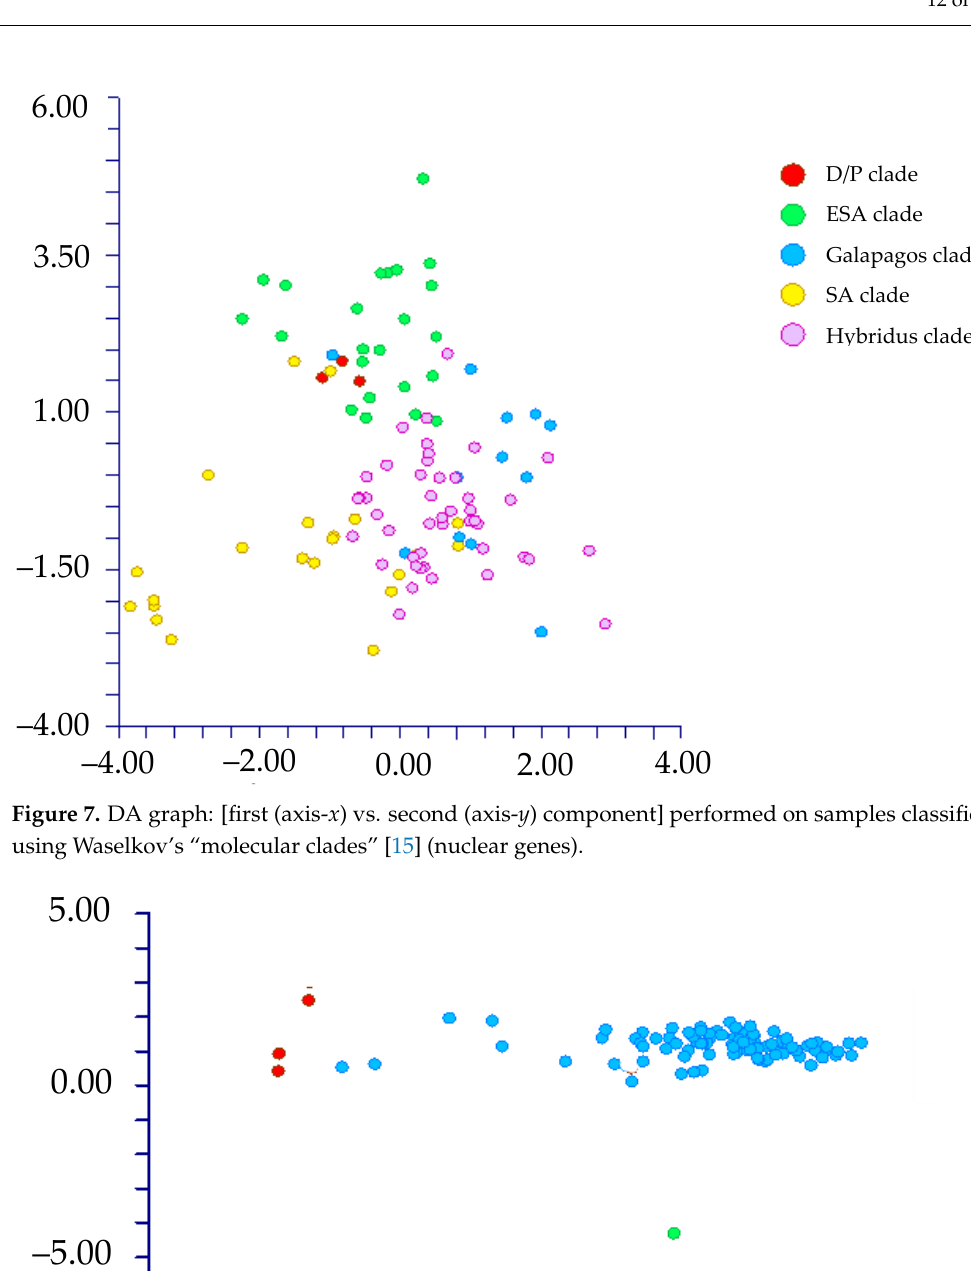
Figure 8. DA graph: [first (axis x ) vs. second (axis y ) component] performed on groups derived from PCA: red dots: crassipes group; green dots: muricatus / viridis group; blue dots: residual group.